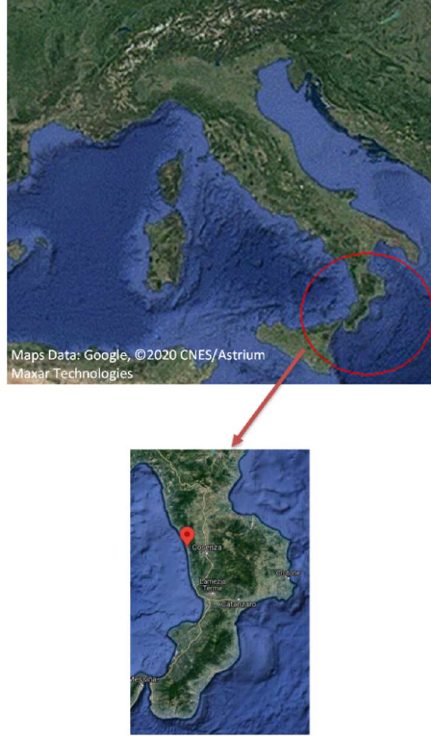
Figure 1. The map of the Calabria region, southern Italy, with the sampling point indicated.